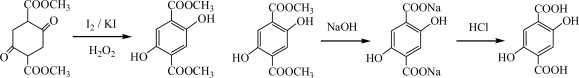
Synthesis of DHTA.